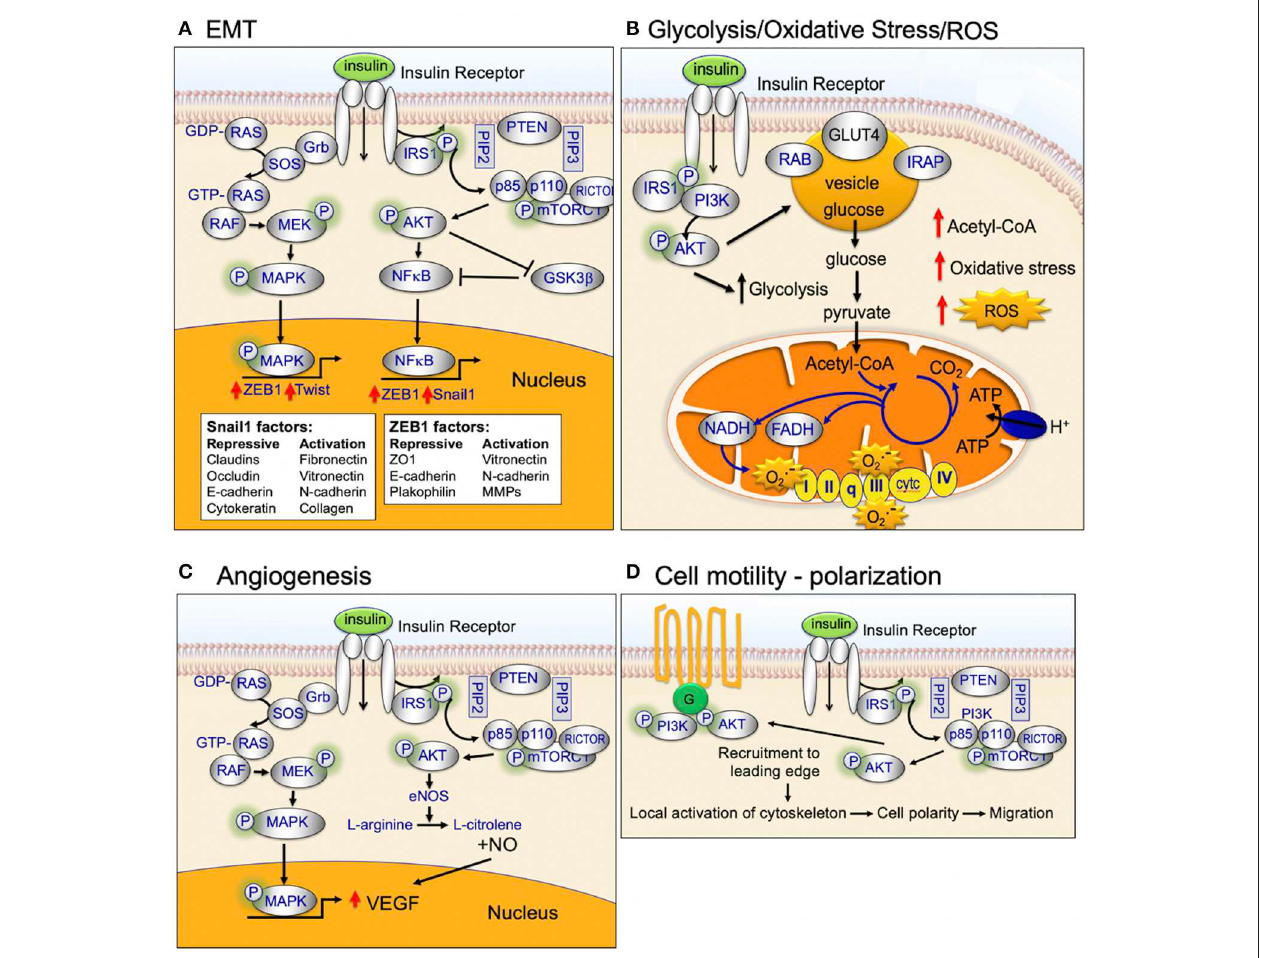
( Figure 6 ) (115–117). Aggressive cancer cells are known to become glucose dependent and generate a larger proportion of to mitochondrial oxidative phosphorylation (TCA cycle)